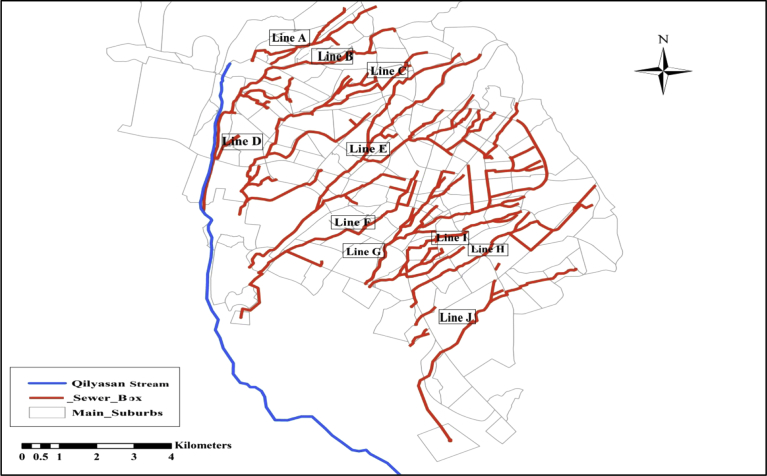
The main sewer box layout of sulaimania city (Directorate of Sewage of Sulaimani, 2017),